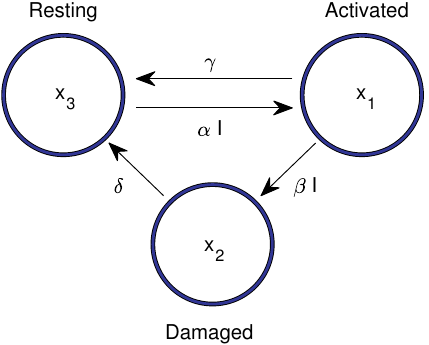
Figure 3. Kinetic model of Eilers and Peters